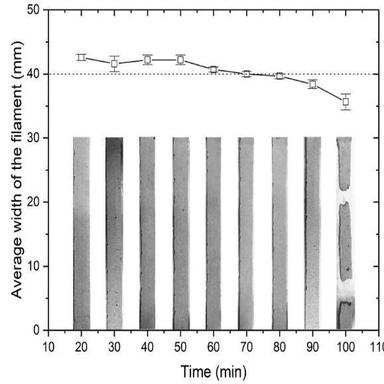
An example of the open time measurement. The width of the nozzle opening used in this test is 40 mm.